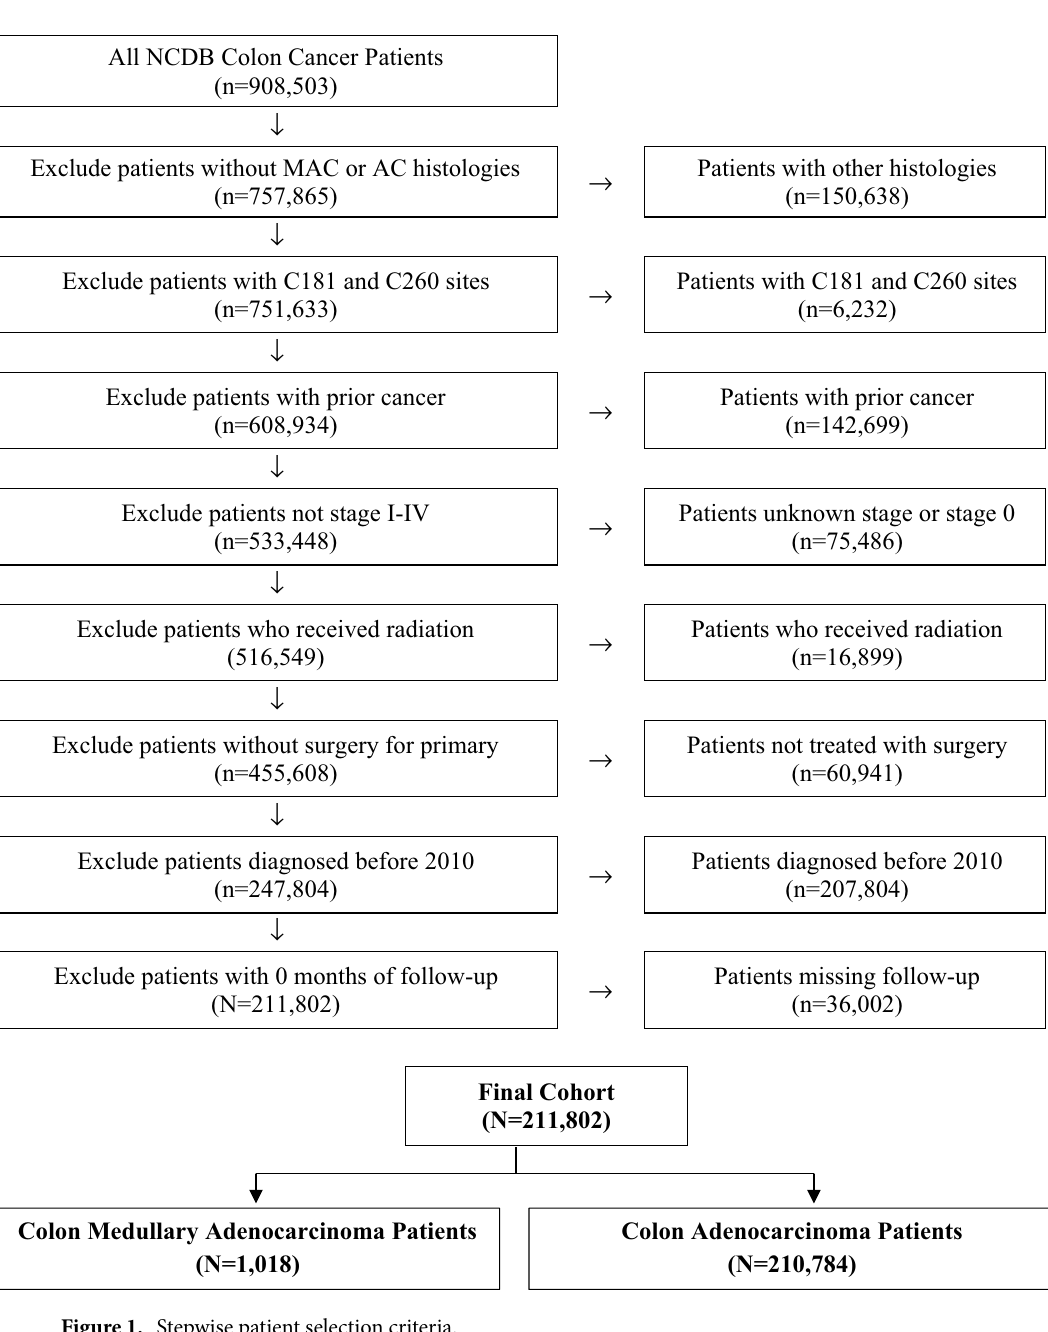
Figure 1. Stepwise patient selection